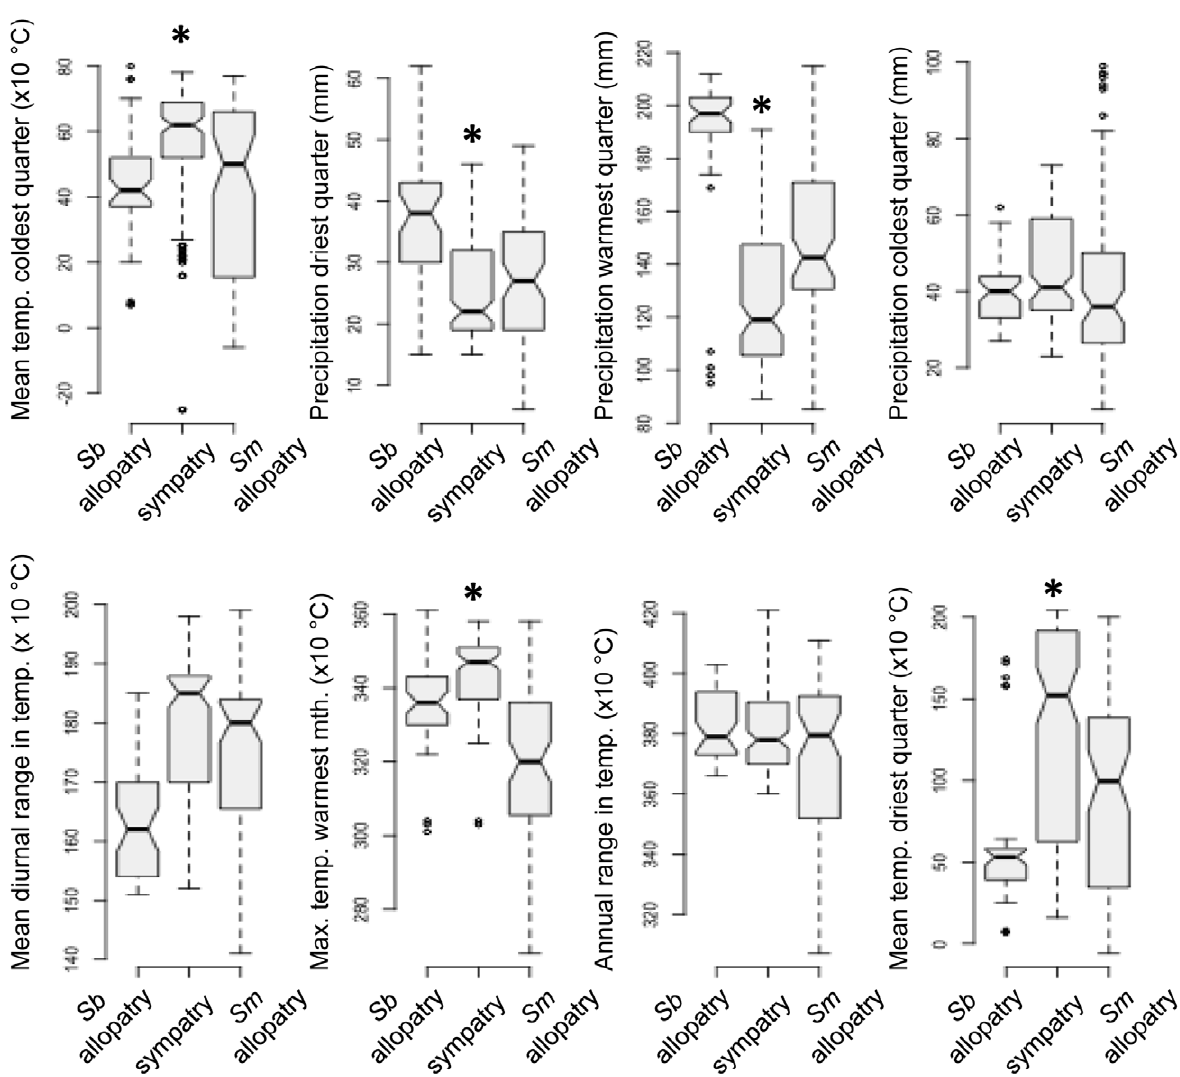
Figure 6. Environmental variation between sympatry and allopatry. Box-and-whisker plots showing environmental space occupied by predicted allopatric populations of S. bombifrons (abbreviated ‘‘ Sb allopatry’’), predicted allopatric populations of S. multiplicata (abbreviated ‘‘ Sm allopatry’’), and predicted sympatric populations of both species for each environmental variable used in the Maxent models. Non-overlapping notches are roughly equivalent to 95% confidence intervals, and therefore provide strong evidence that the medians differ [48,58]. An ‘‘*’’ above the sympatry box indicates variables for which sympatric sites are significantly hotter or drier than both allopatric sites.